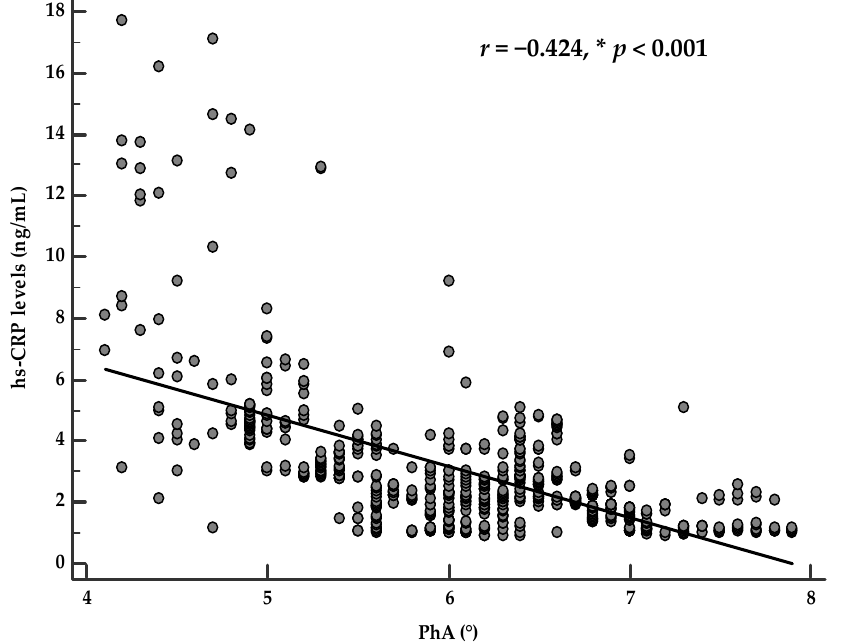
Figure 1. Correlation between PhA and inflammatory marker after adjusting for age, physical activity, BMI, WC, and PREDIMED score, in male participants. * A significant difference ( p < 0.05).